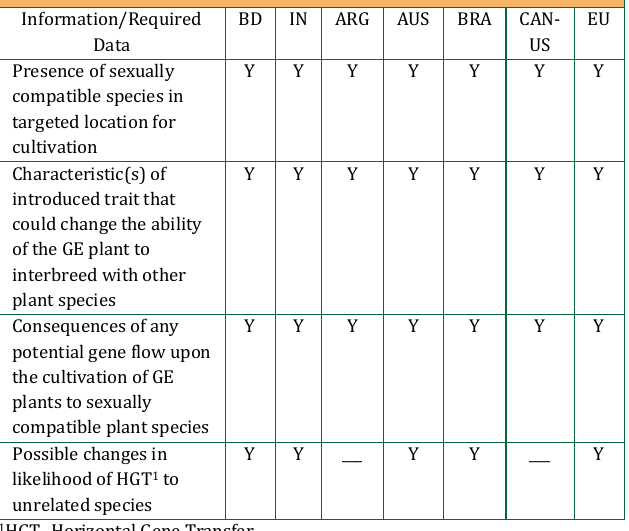
Table 6: Impact of Outcrossing with Sexually Compatible